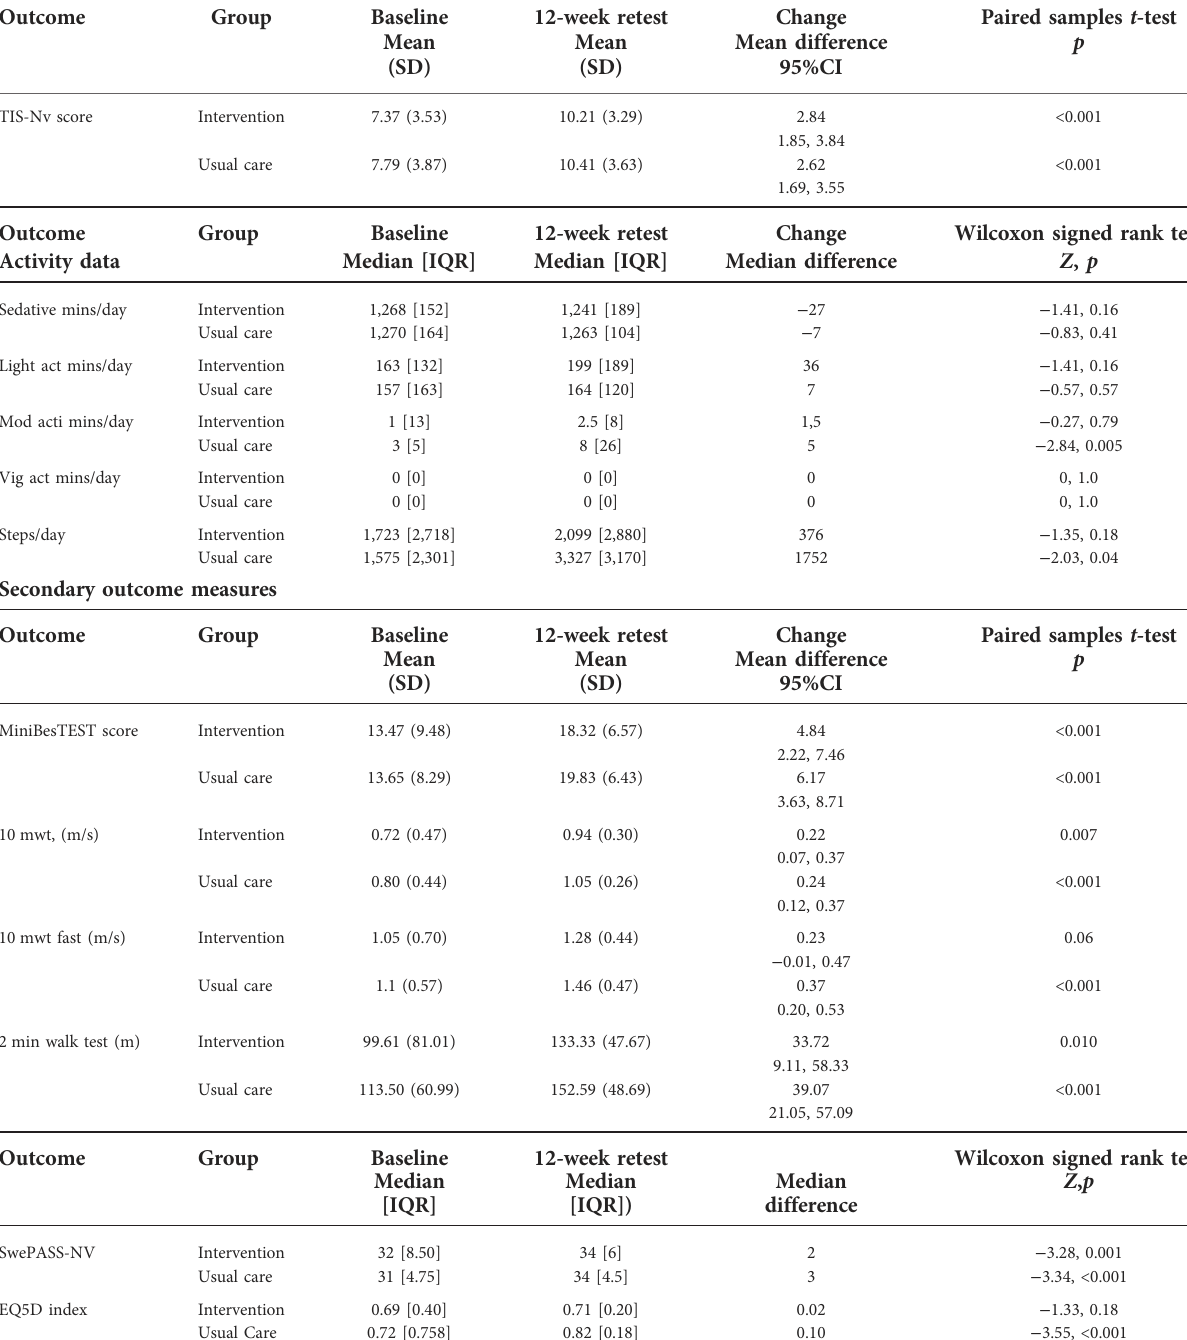
TABLE 4 Within-group